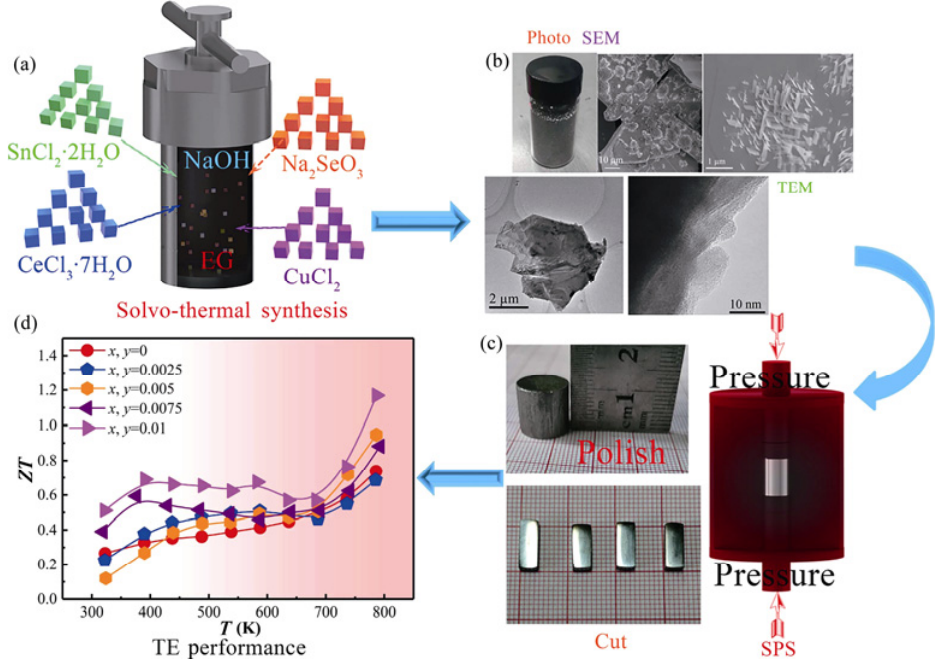
Fig. 1 Illustrations of co-doping SnSe (Sn 1 − x − y Ce x Cu y Se): (a) fabrication process; (b) sintering process; (c) testing sample; and (d) obtained ZT values along perpendicular